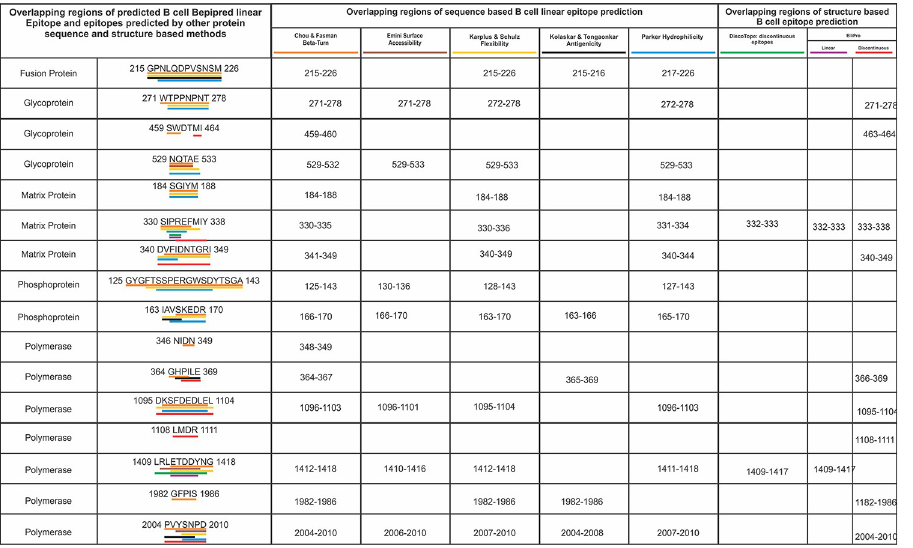
Fig 2. Overlapping regions amongst the linear B cell epitopes predicted by the BepiPred method and other seven different B cell epitopes prediction methods. B cell epitopes predicted by the BepiPred method and other different protein sequence based (Chou.., Emini.., Karplus.., Kolaskar.., and Parker..) and protein structure based (DiscoTope and ElliPro) prediction methods were found to have significant consensus. Consensus overlapping regions of BepiPred epitopes are underlined by the different color, corresponding to respective prediction